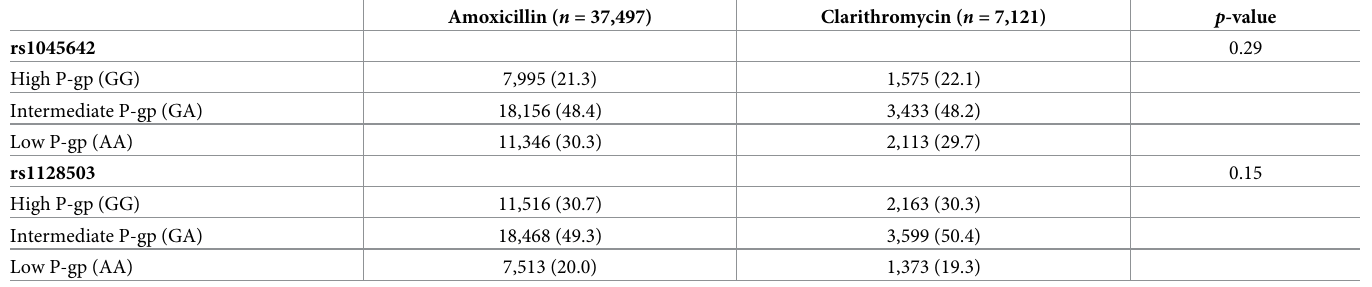
Table 4. Pharmacogenomic cohort population stratified by genotype and number of